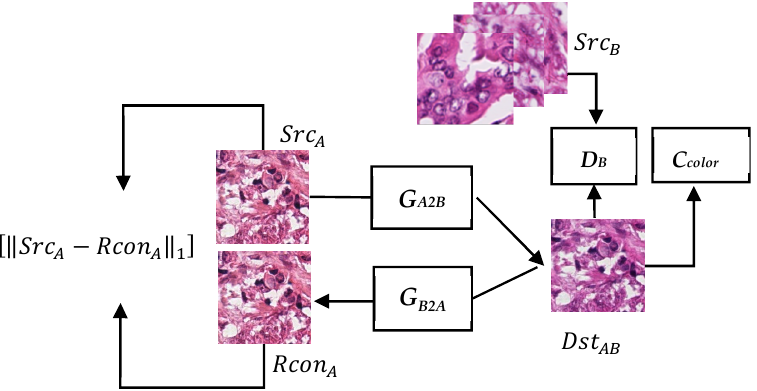
Figure 3. System architecture of the S3CGAN.